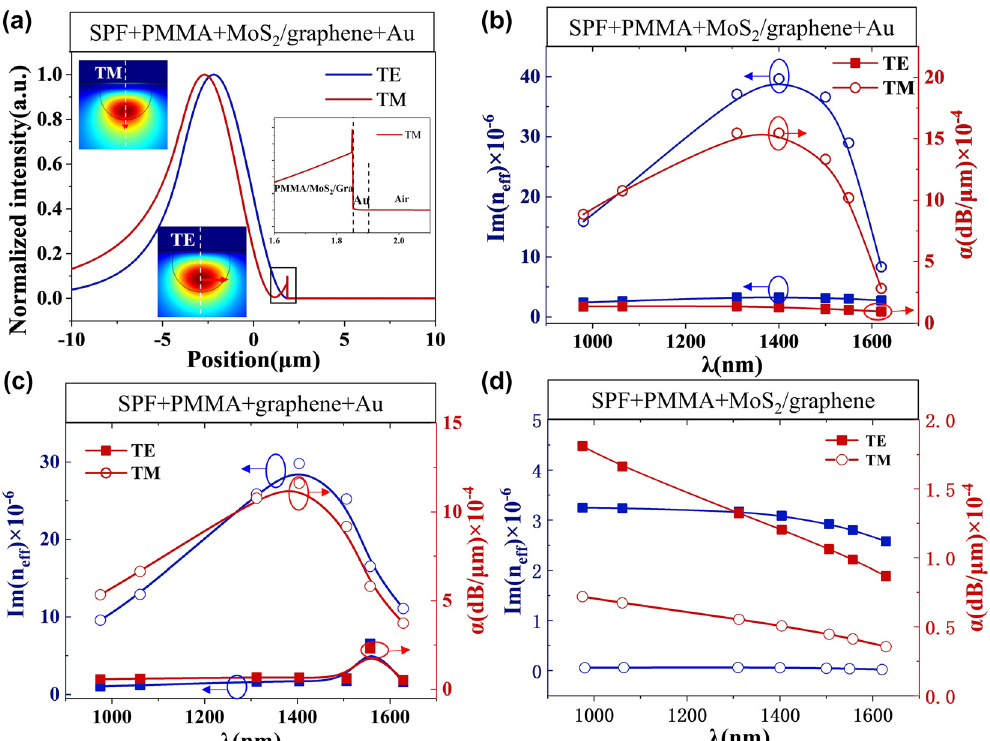
Figure 2: The simulation results. (a) Normalized intensitiesalong the whitedotted linesfrom TMand TE modes,the insetsincludeTM andTE modesoptical fielddistributionat 1550 nm and the enlarge view of TM mode normalized intensity; (b) imaginary parts of the effective refractive indices Im( n eff ) and absorption coef fi cients α as a function of the wavelengths (980, 1064, 1310, 1400, 1500, 1550, and 1620 nm) with MoS 2 /Graphene/Au, (c) without MoS 2 , and (d) without Au fi lm,